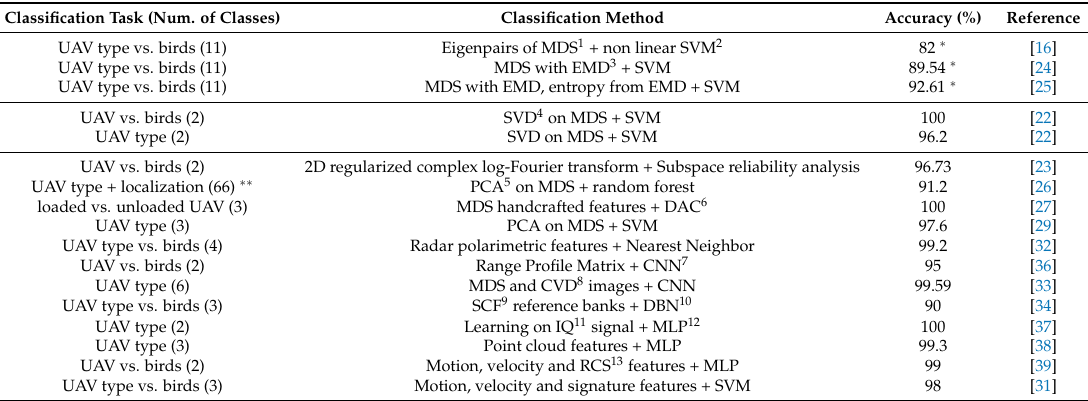
Classification Task (Num. of